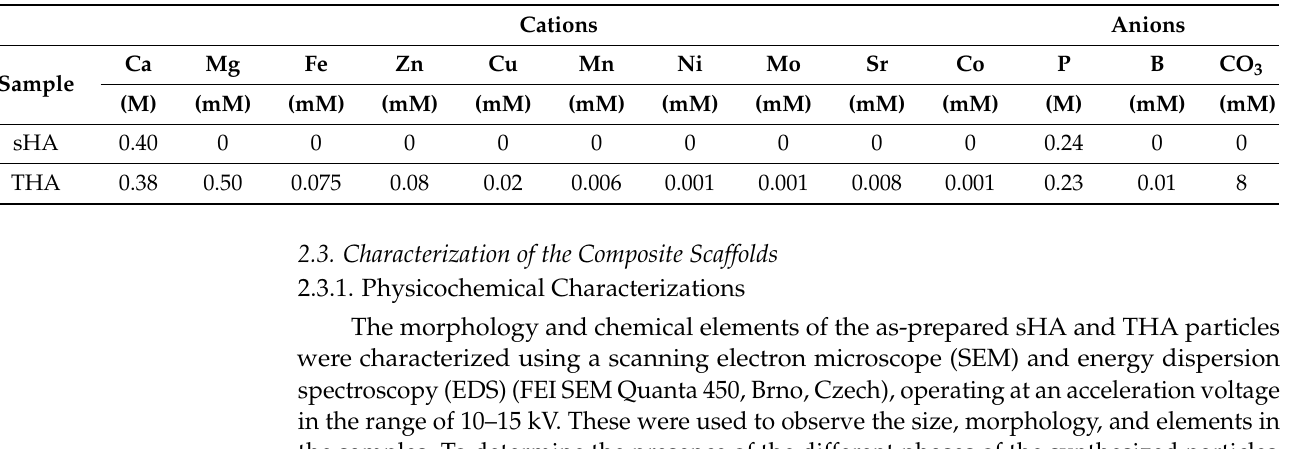
Figure 1. Scheme for multi-trace elements co-doped hydroxyapatite (THA) powders obtained by precipitation reactions. Table 1. The molar concentrations of the elements used in the preparation of pure (sHA) and doped hydroxyapatite